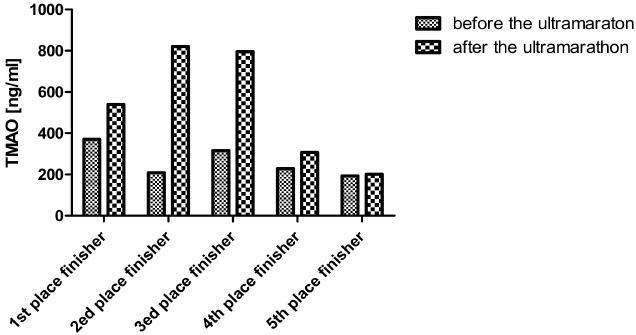
Figure 2. Changes in TMAO in 5 first runners who completed the 100-km race. All the runners were male. Abbreviations: TMAO—trimethylamine N-oxide.